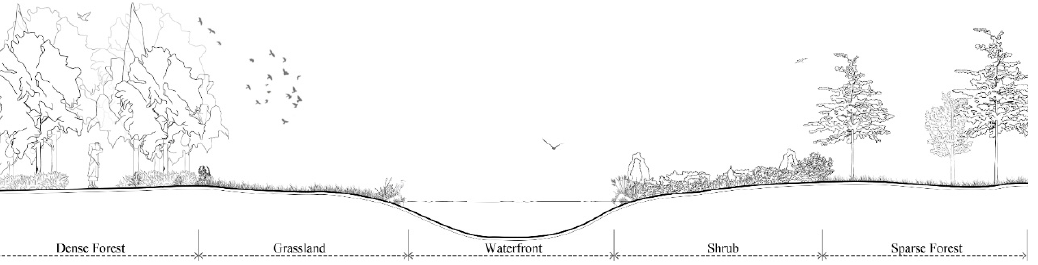
Figure 2. Schematic diagram of five typical vegetation habitats in urban mountain parks. From left to right are dense forest habitat, grassland habitat, waterfront habitat, shrub habitat, and sparse forest habitat.